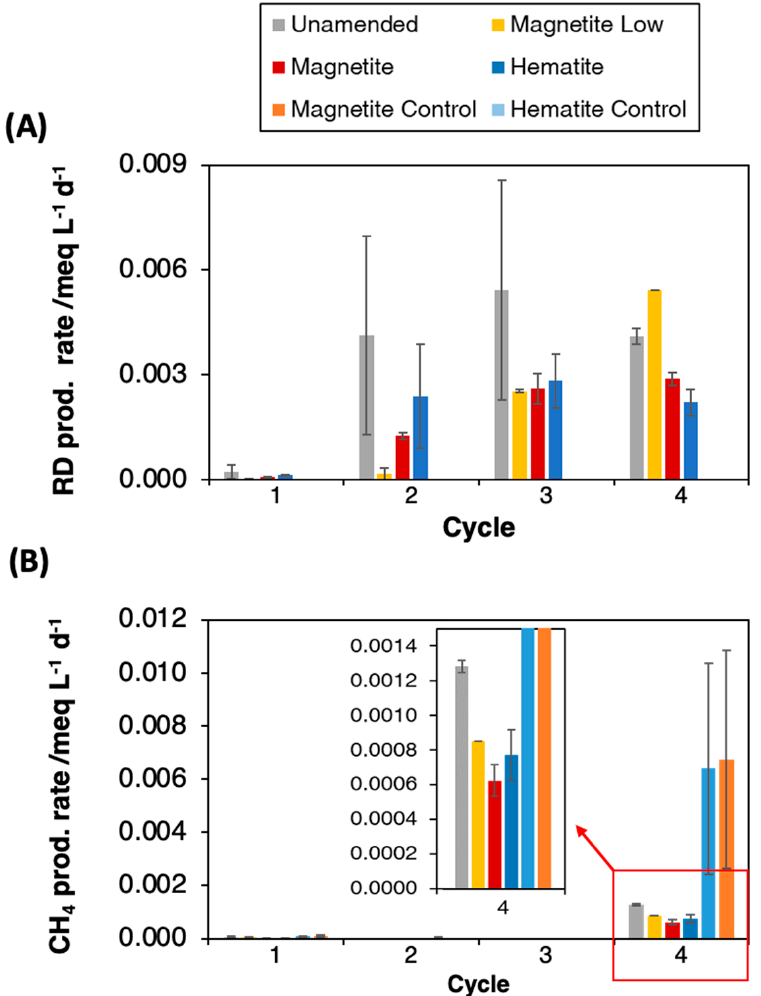
Figure 5. For each treatment during the different feeding cycles: ( A ) average RD production rate; ( B ) CH 4 generation.